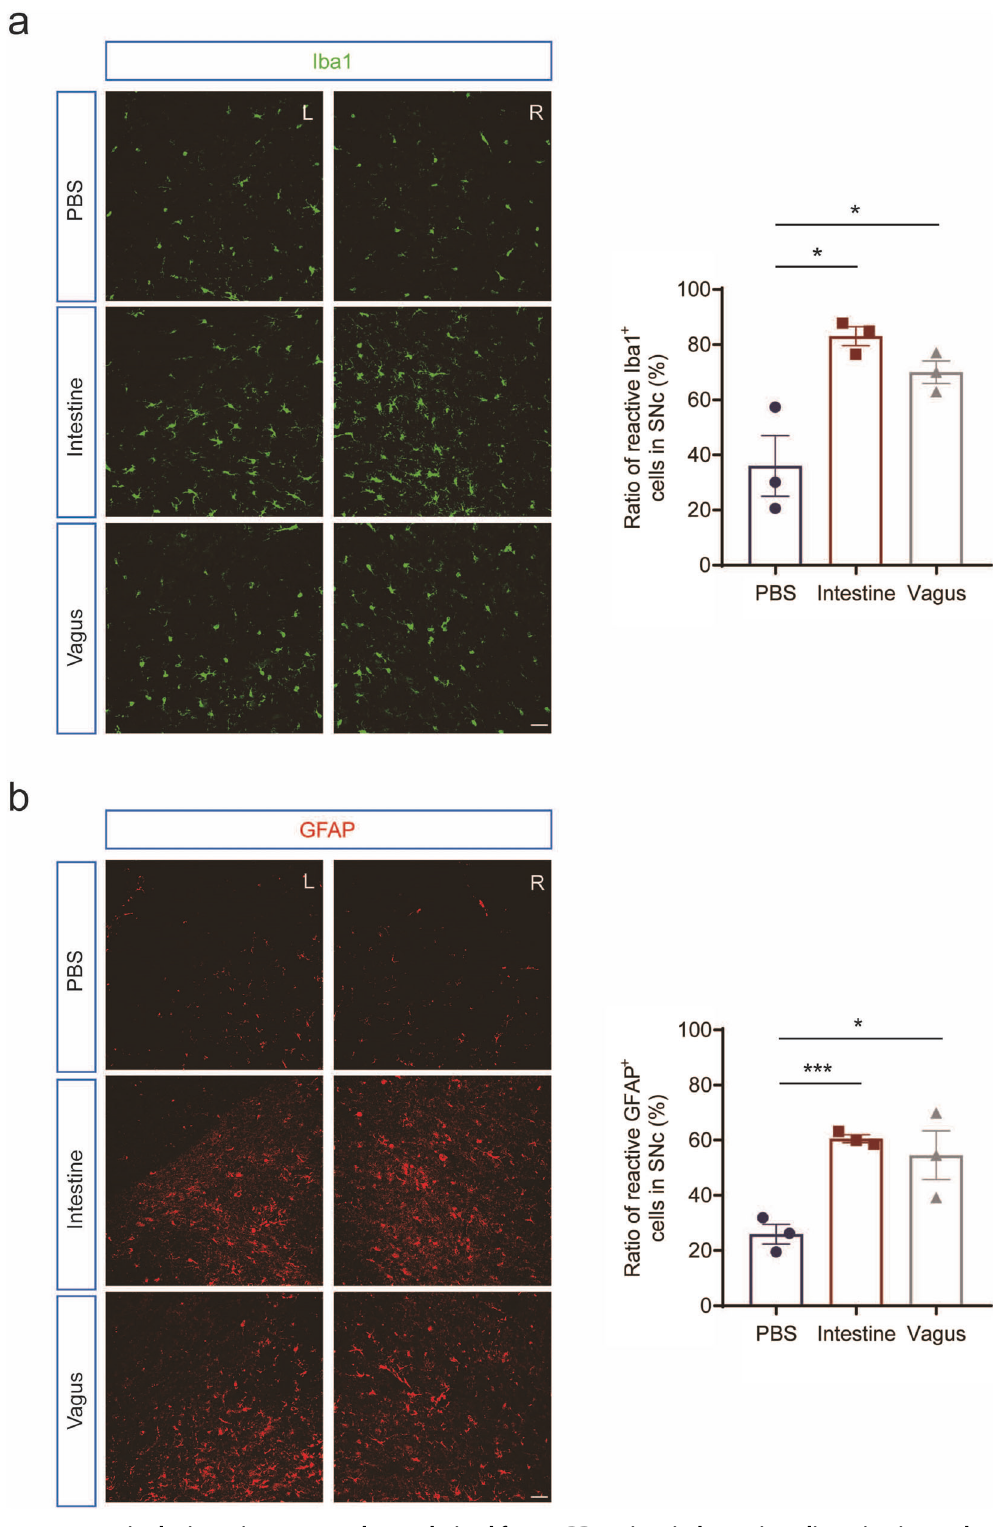
Fig. 6 The α -syn aggregates in the intestine or vagus lysate derived from a PD patient induce microglia activation and astrogliosis in the SNc. Immuno fl uorescence is depicted for Iba1 + microglia ( a ) and GFAP + astrocyte ( b ) in the ipsilateral and contralateral SNc of intestine or vagus lysate-injected rats. Scale bars, 25 μ m. The ratios of reactive Iba1 + and GFAP + cells are quanti fi ed in the SNc of intestine or vagus lysate- injected rats. Unpaired t-test. Iba1, * p = 0.015 (Intestine); * p = 0.0443 (Vagus); GFAP; *** p = 0.0009 (Intestine); * p = 0.0403 (Vagus). GFAP glial fi brillary acidic protein, Iba1 ionized calcium-binding adapter molecule 1, L ipsilateral left brain, R contralateral right brain.